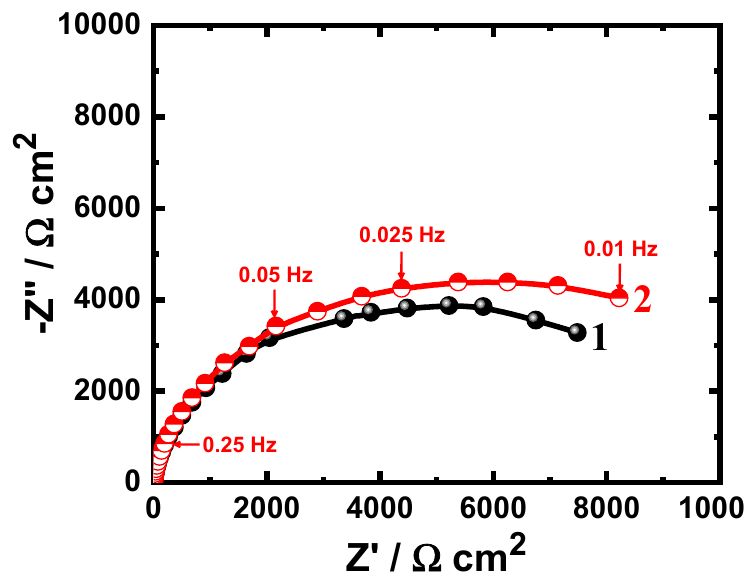
Figure 4. Nyquist plots of ( 1 ) uncoated API-2H steel and ( 2 ) 75%Cr 3 C 2 − 25%NiCr coated API-2H steel after 1 h immersion in 4% NaCl solutions.